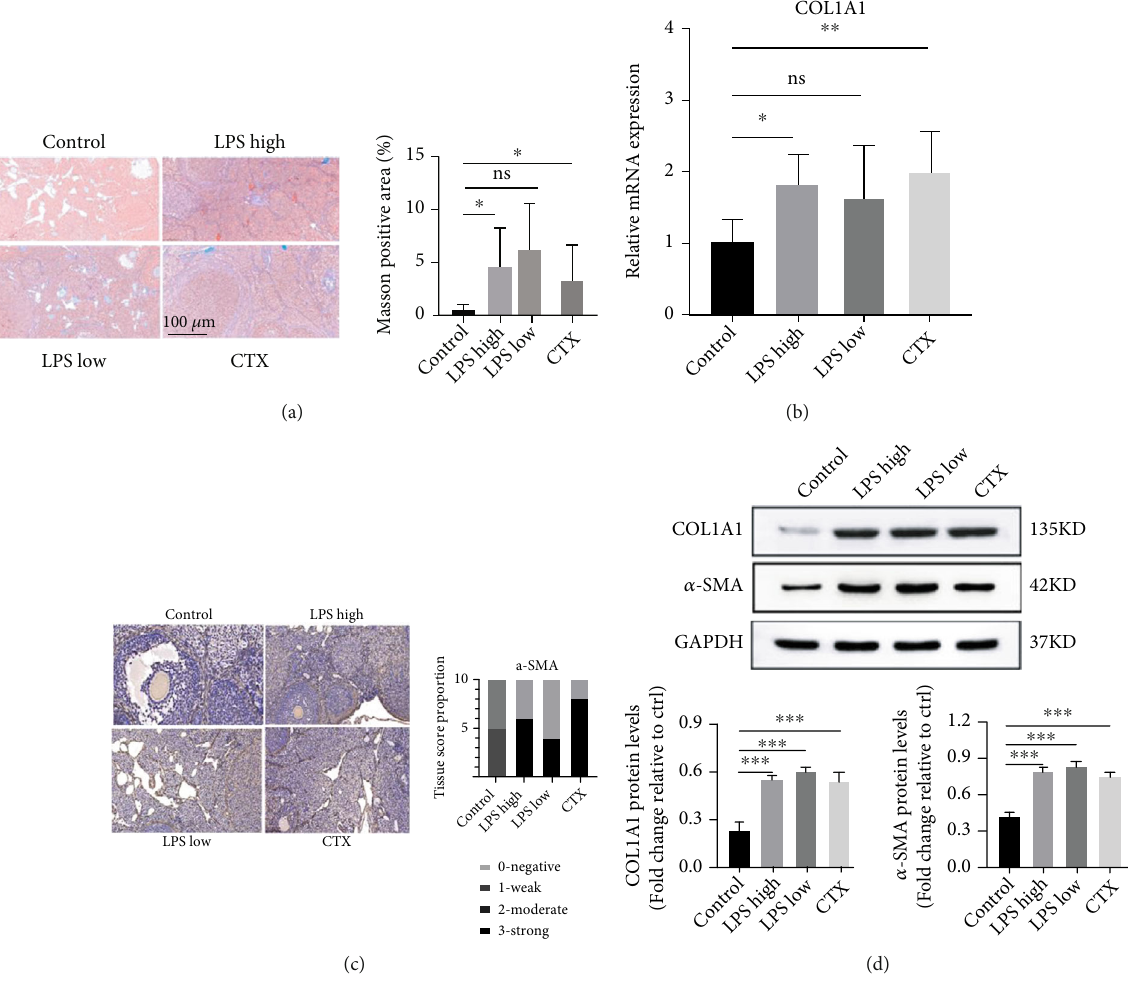
Figure 3: LPS stimulation induced ovarian fi brosis in mice. (a) Masson staining was performed to detect collagen deposition in mouse ovaries. Representative images are shown. Scale bar: 100 μ m. (b) qRT-PCR was performed to determine Col1A1 mRNA expression in the mouse ovaries. (c) Immunohistochemical staining was carried out to detect α -SMA expression in the mouse ovaries. Representative images are shown. Scale bar: 100 μ m. (d) Western blotting was performed to determine protein expression of Col1A1 and α -SMA in the mouse ovaries. Data are expressed as the mean ± SEM . ∗ P < 0 : 05 , ∗∗ P < 0 : 01 , and ∗∗∗ P < 0 : 001 , n = 10 . Col1A1: type I procollagen; α - SMA: α -smooth muscle